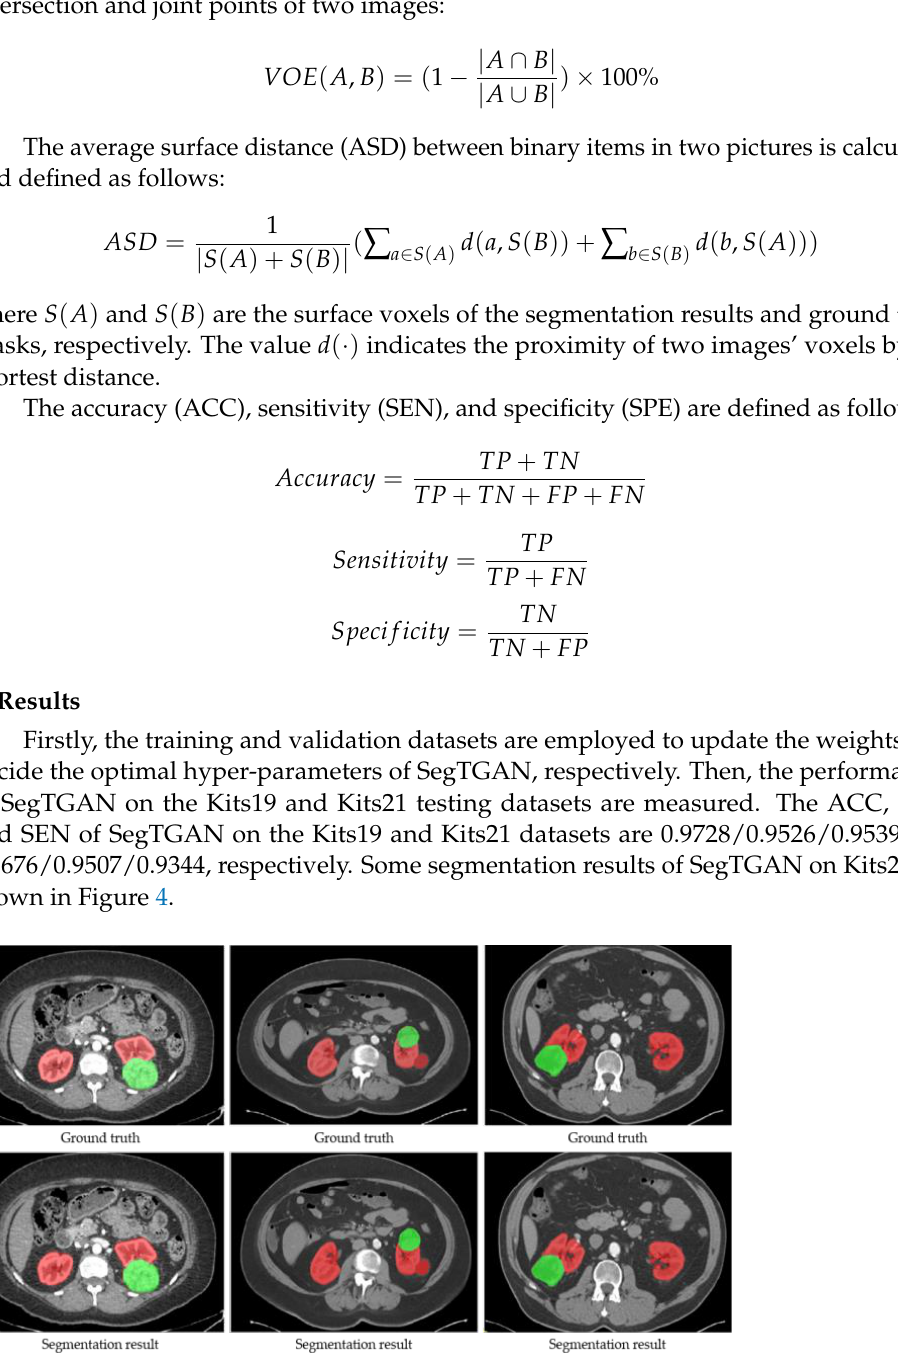
Figure 4. Examples of the segmentation results of SegTGAN on the Kits21 dataset. Red contour denotes the kidney and green contour denotes a tumor.